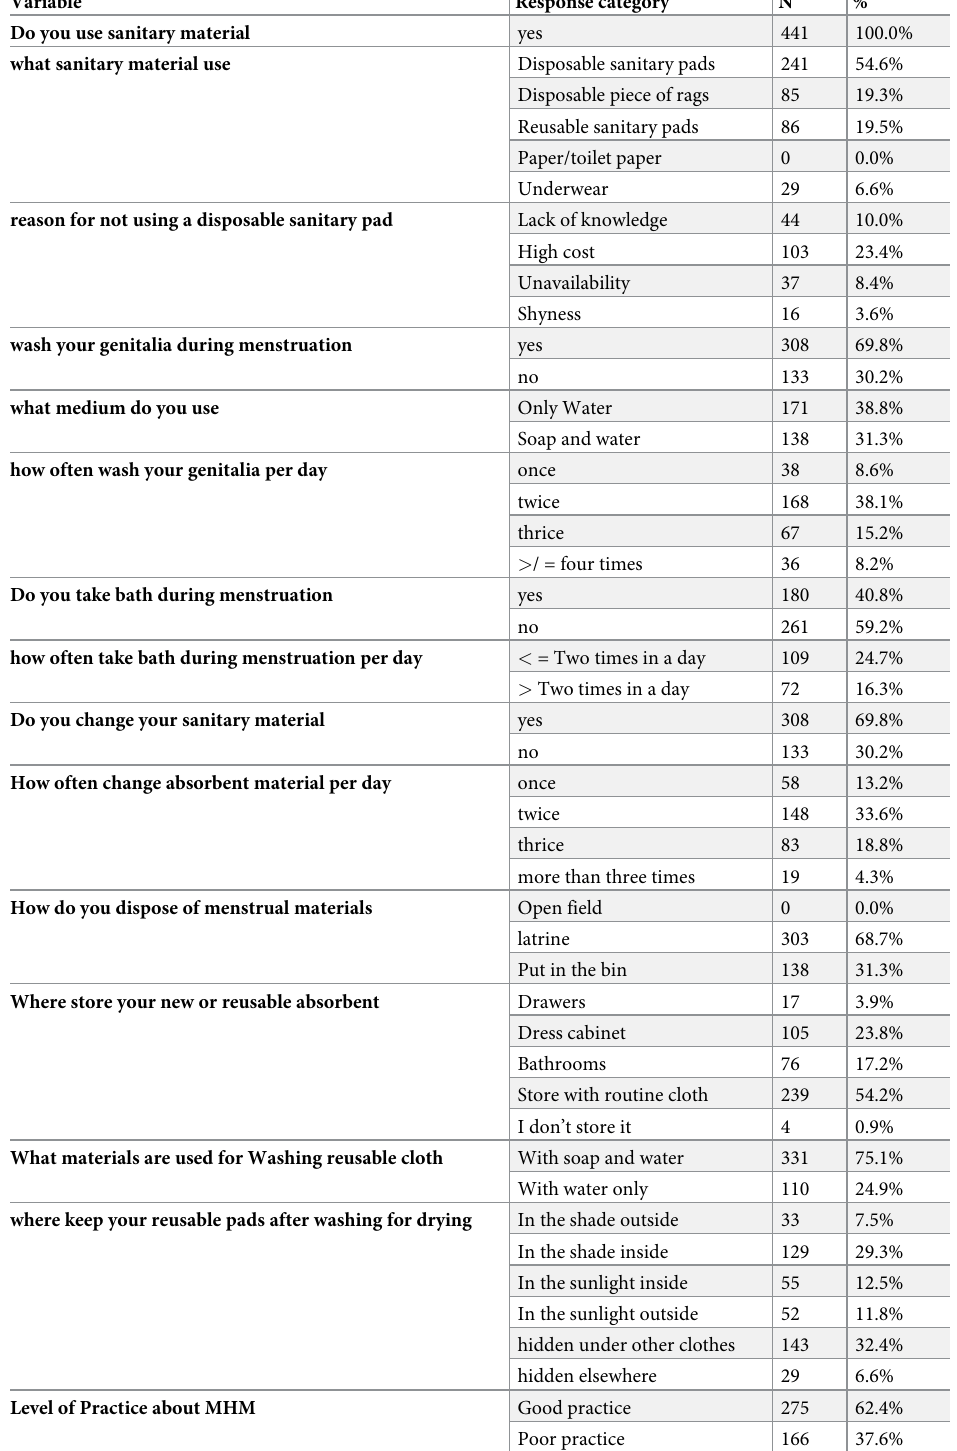
Table 4. Respondents Overall practice on menstrual hygiene management in Mekdela secondary school, Amhara regional state, Northeast Ethiopia, 2020 (n =